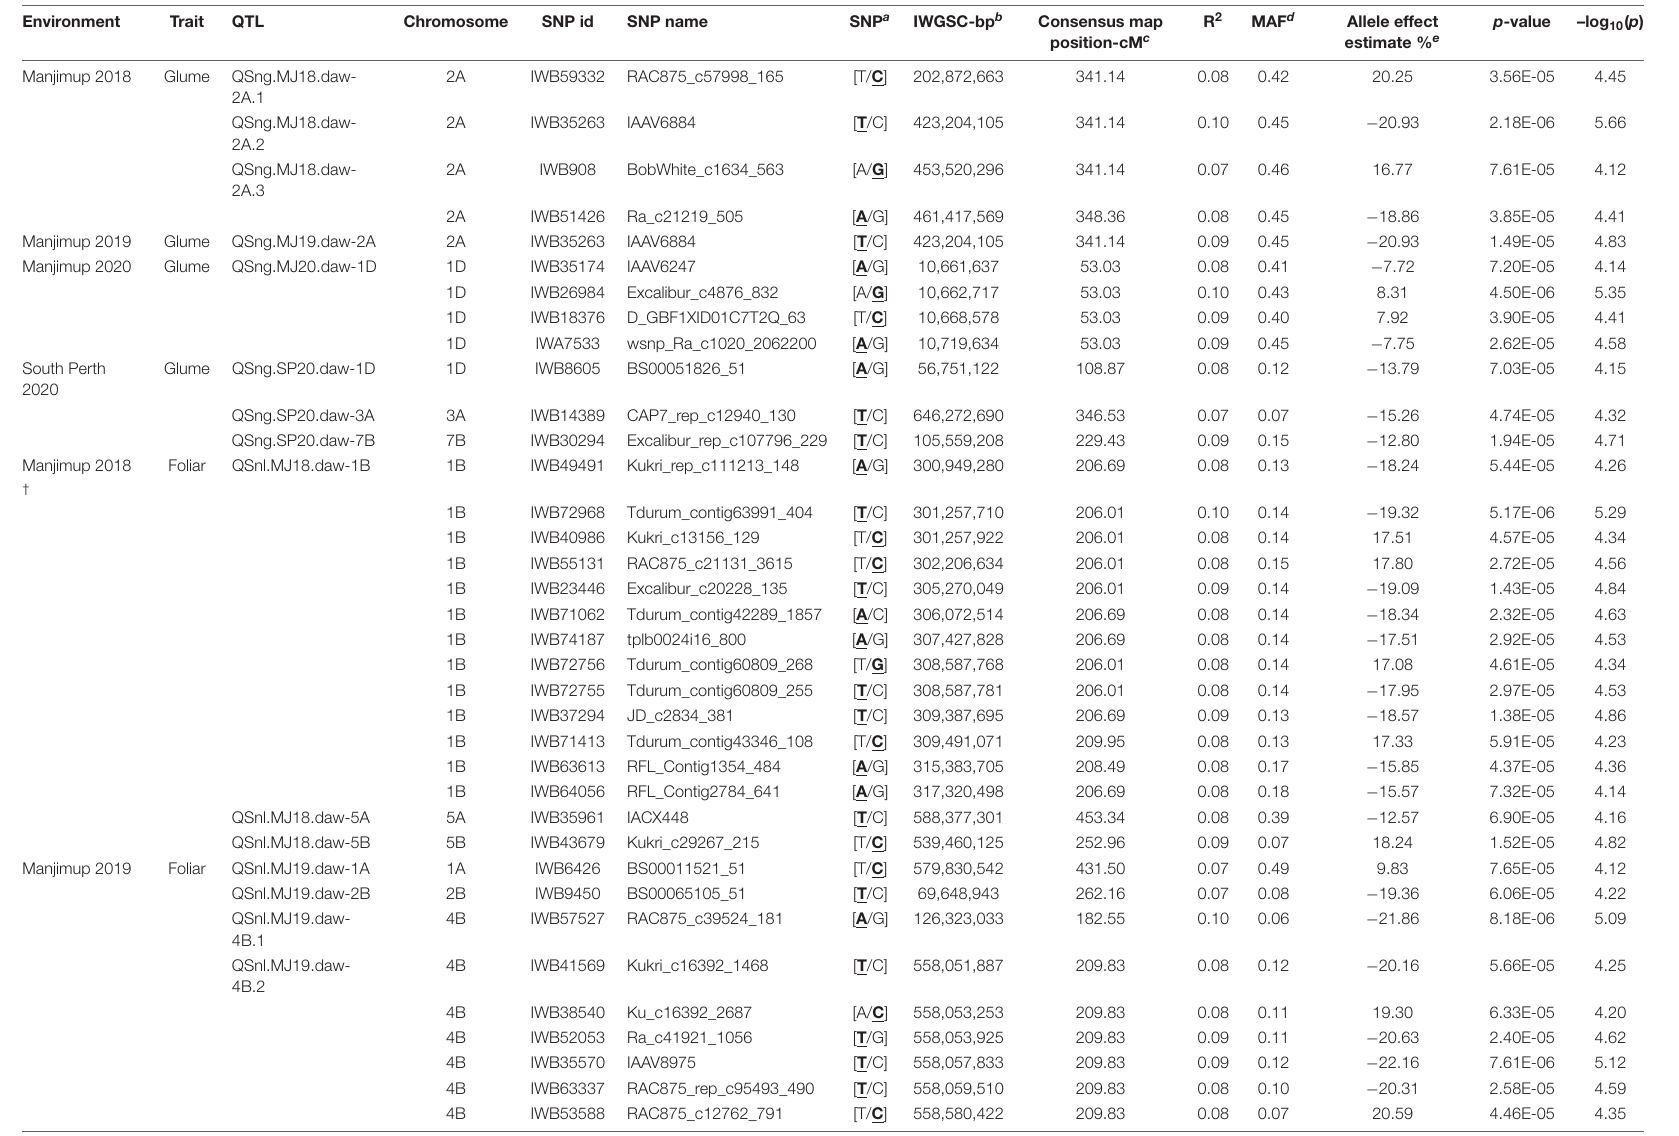
TABLE 7 | Summary of marker trait associations for PGAD (glume) and PLAD (foliar) scores from four Western Australian environments in